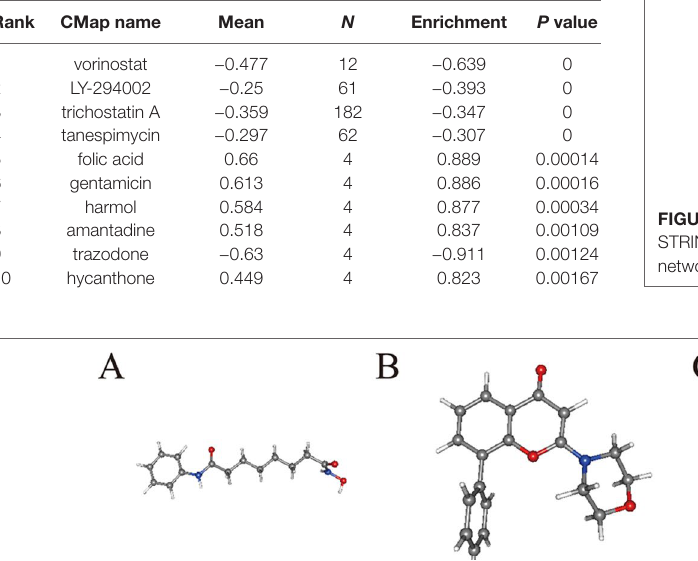
FIgUrE 4 | Three-dimensional diagram of the three most significant drugs. (A) Vorinostat, (B) LY-294002, (C) trichostatin A, (D) tanespimycin.